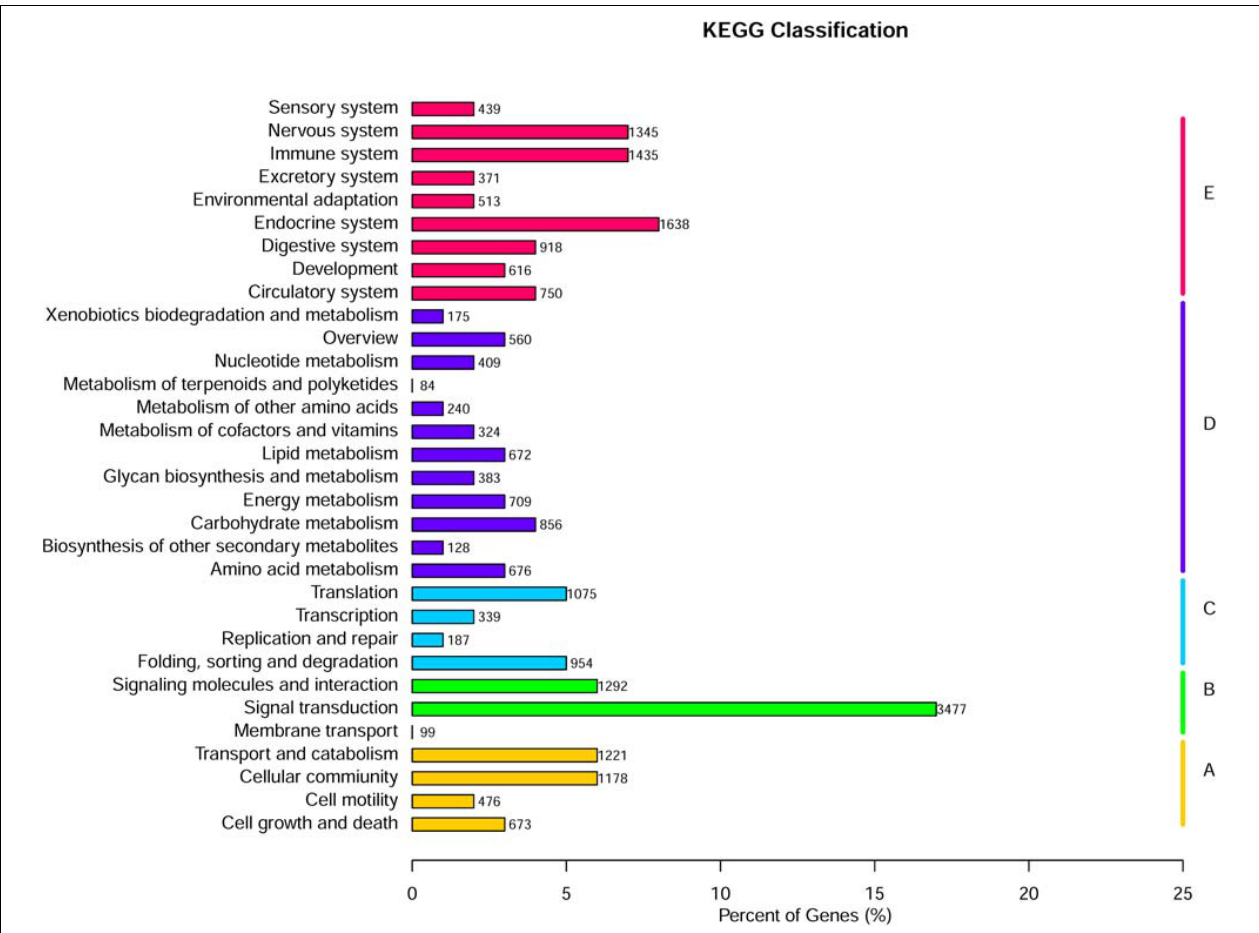
FIGURE 3 | KEGG classification of Gymnocypris eckloni genes. A, cellular processes; B, environmental information processing; C, genetic information processing; D, metabolism; E, organismal